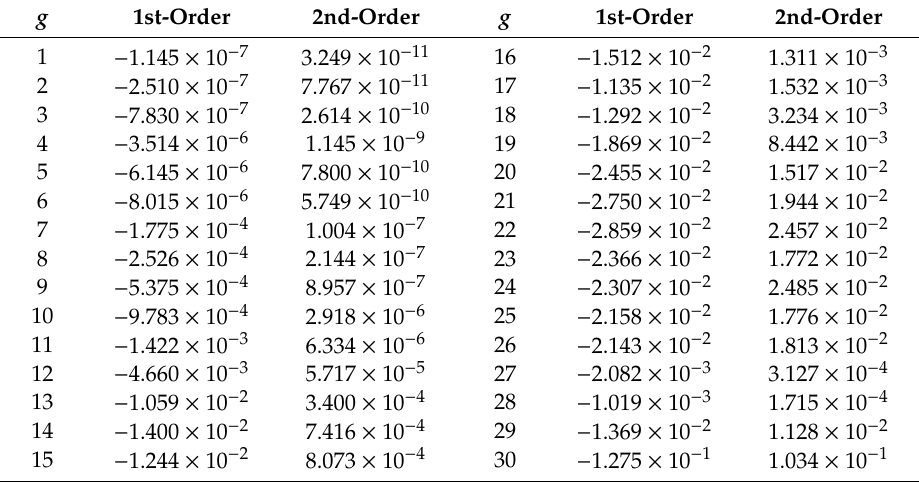
Table 19. Comparison of 1st-order relative sensitivities 2nd-order unmixed relative sensitivities cross sections for isotope 1 ( 239